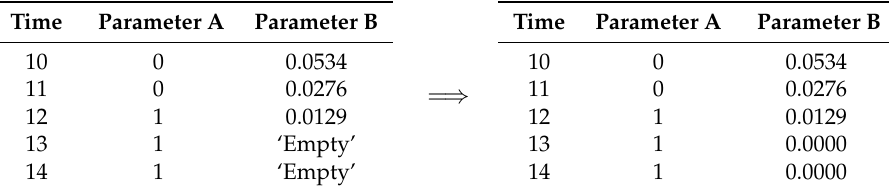
Table 2. Notional process for FOQA data